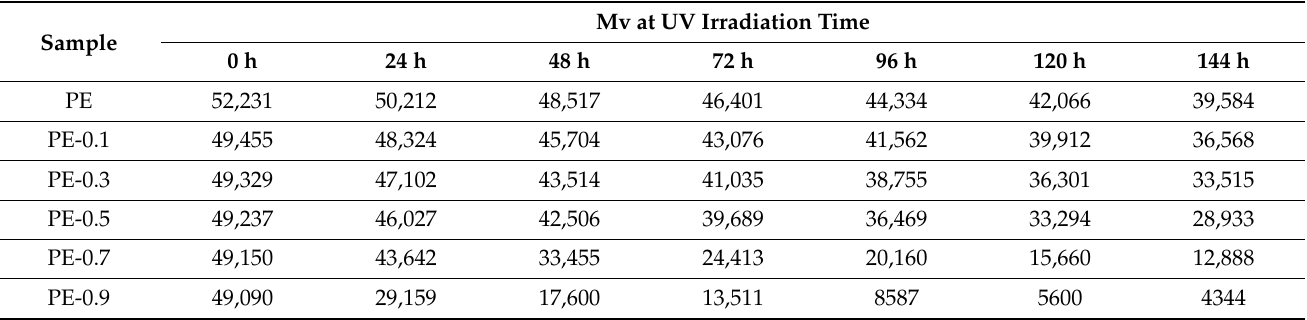
Figure 7. ( a ) Molecular weight changes of LLDPE film and PE-Fe-MMT sample films under different UV irradiation times and ( b ) the corresponding rate curves. Table 6. Mv Changes of PE and PE/Fe-MMT films under different UV irradiation